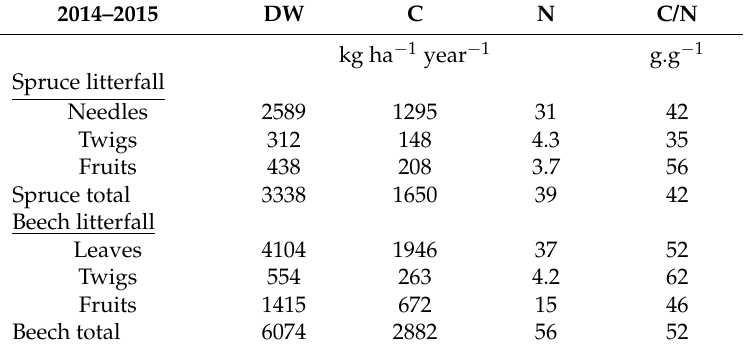
Table 8. Biomass (dry weight), carbon and nitrogen fluxes (kg · ha − 1 · year − 1 ) and respective mass C:N ratios in individual litterfall compartments in spruce and beech